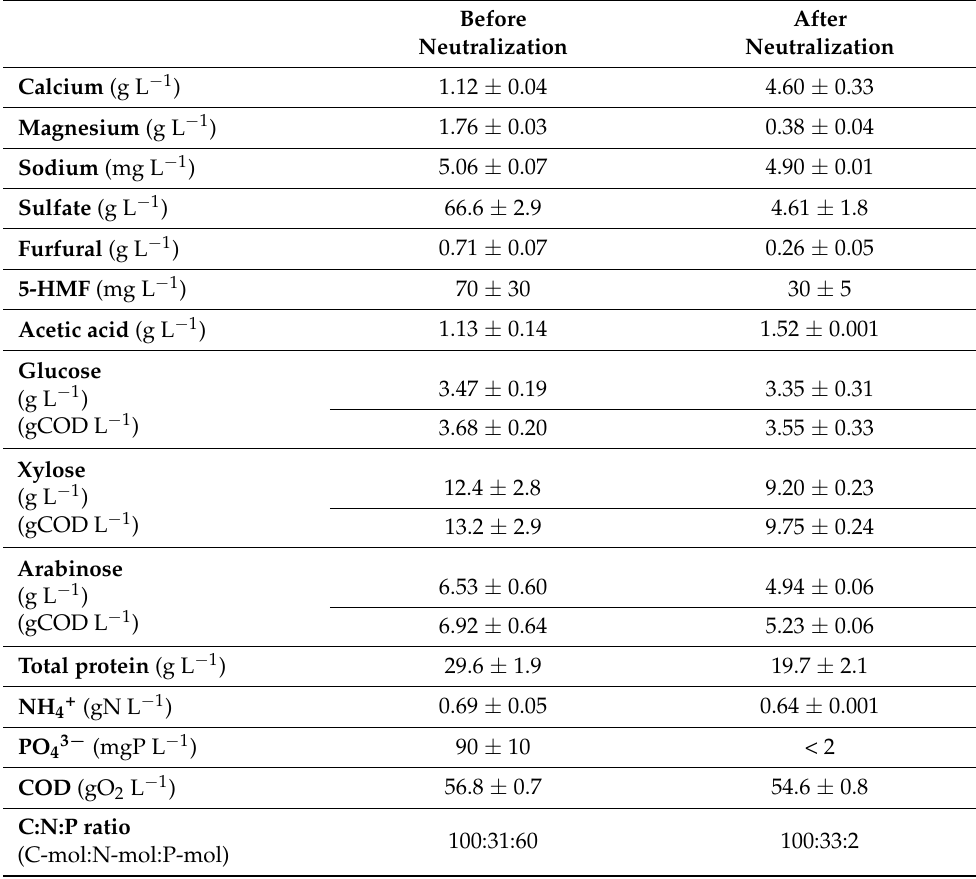
Table 3. Characterization of BSG hydrolysate before and after neutralization.